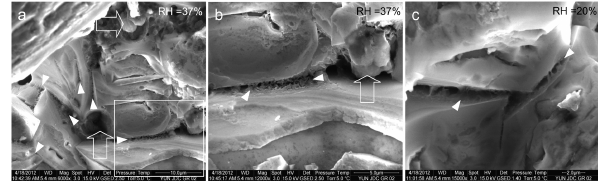
Fig. 7. ESEM images of halite large crystals and grain boundaries equilibrated at low RH. (a) General view shows grain boundaries among halite crystals (white arrowheads) and microbial cell aggre- gates (open white arrows) equilibrated at RH 37%. (b) Detailed ESEM image from the square area in (a) the nano-porous phase (white arrowheads) filling the grain boundary; the white open arrow points to the microbial cell aggregate. (c) The ESEM image shows the nano-porous phase (white arrowheads) filling the grain bound- ary; halite equilibrated at RH 20%.